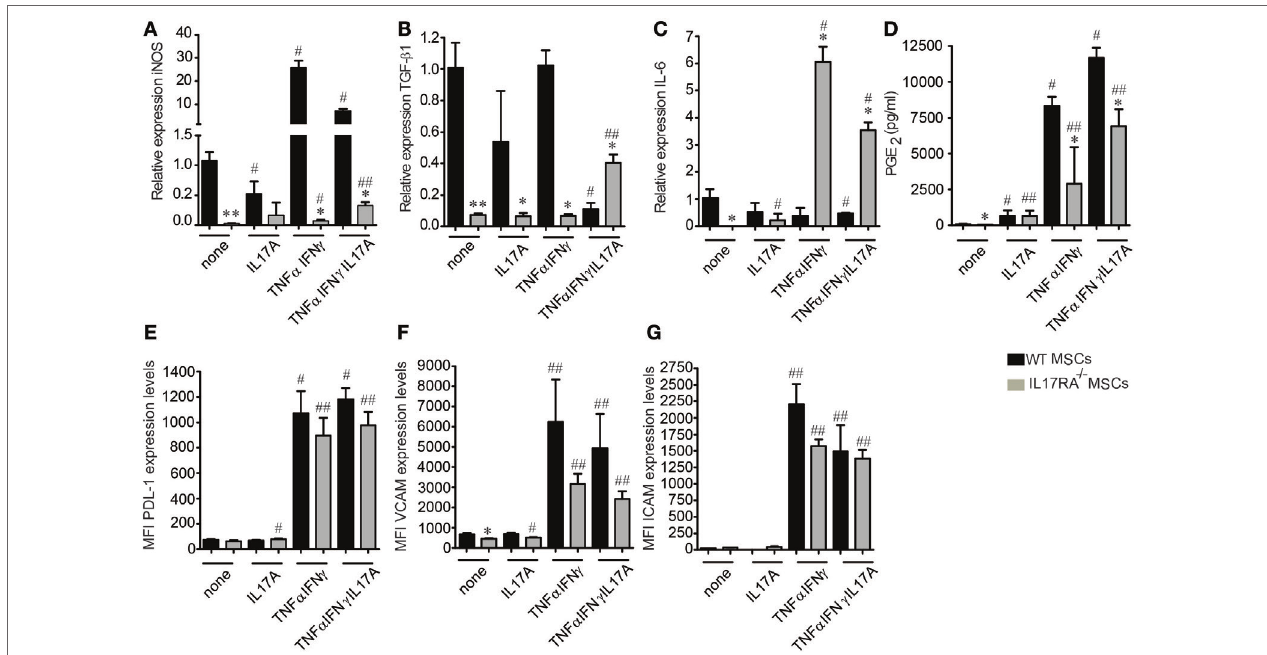
FigUre 3 | Mesenchymal stem cells (MSCs) deficient for IL17RA produce less suppressive factors associated to MSCs immunomodulatory properties. (a–c) Expression profile of inducible nitric oxide synthase (iNOS) (a) , transforming growth factor β 1 (B) , and IL6 (c) on wild-type and IL17RA − / − MSCs evaluated by quantitative real-time PCR. The cells were either inactivated (none) or activated (IL17A, TNF α , and IFN γ or TNF α , IFN γ , and IL17A) for 24 h. (D) Prostaglandin E2 quantification by enzyme-linked immunosorbent assay from 24 h culture supernatants of MSCs activated or not with IL17A, TNF α , and IFN γ or TNF α , IFN γ , and IL17A. (e–g) FACS quantification of PD-L1 (e) , VCAM1 (F) , and ICAM1 (g) on inactivated or activated MSCs (IL17A, TNF α , and IFN γ or TNF α , IFN γ , and IL17A) for 24 h. Statistical differences were calculated using the Kruskal–Wallis test. Each treatment was compared with its respective control ( # ) and between the respective treated condition in wild-type MSCs (*). Mean values of at least three independent experiments. *,# P < 0.05, **,## P < 0.01.